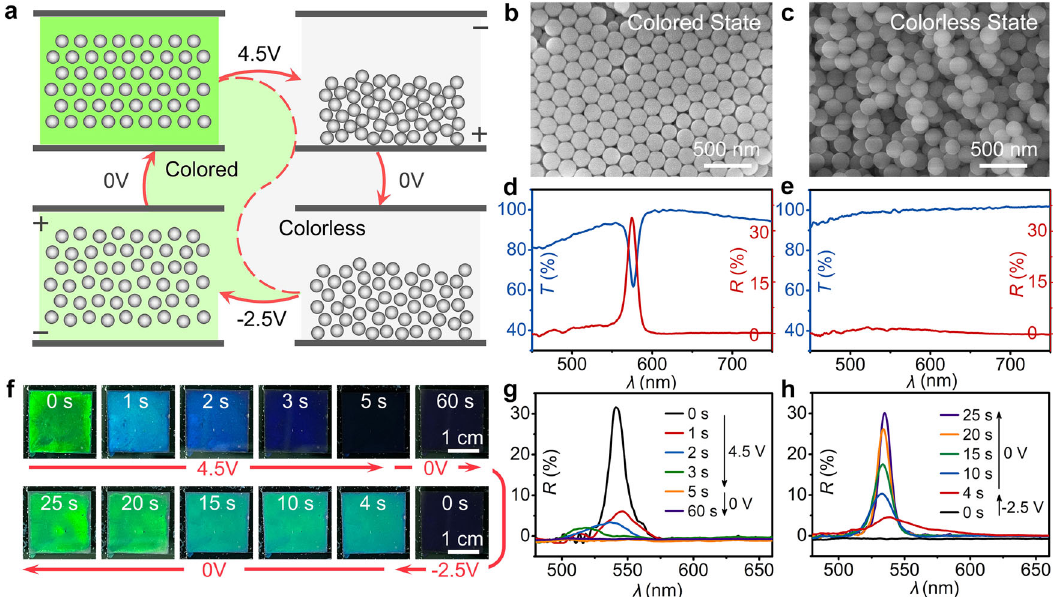
Fig. 1 | ERPC with bistableand switchable characteristics.a Structure changeof theSiO 2 /PCb-PEG-EGERPC(30/60/5/5vol%)asitwasswitchedbetweenthecolored state and the colorless state by an electric fi eld; b , c SEM images, and d , e the